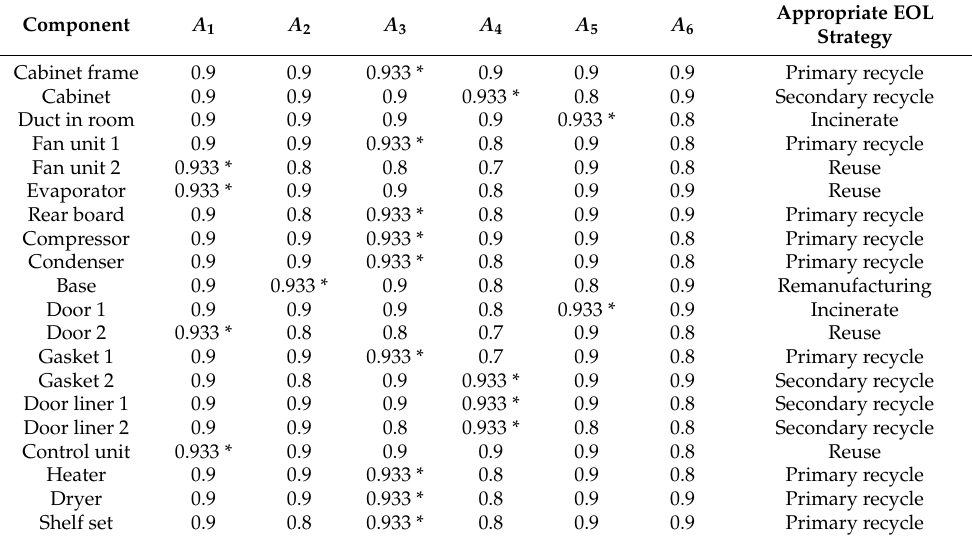
Table 9. Refrigerator component relevant closeness RC and appropriate EOL strategy.